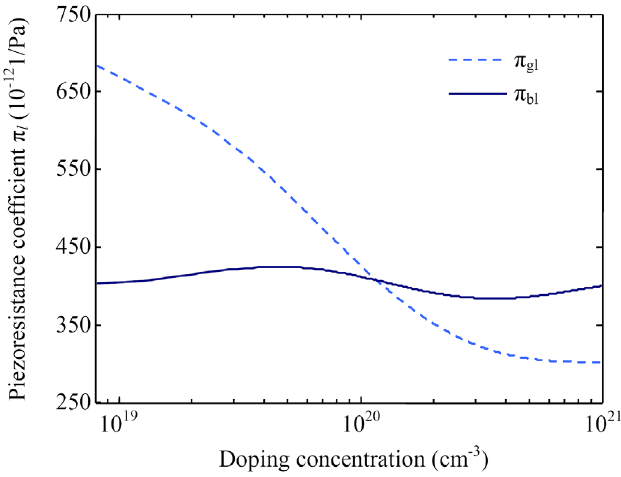
and π on the doping concentration N bl gl